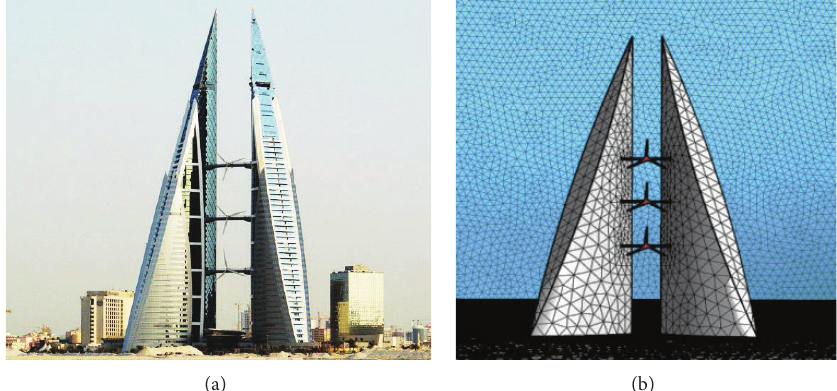
Figure 3: (a) Actual building configuration, (b) meshed model.